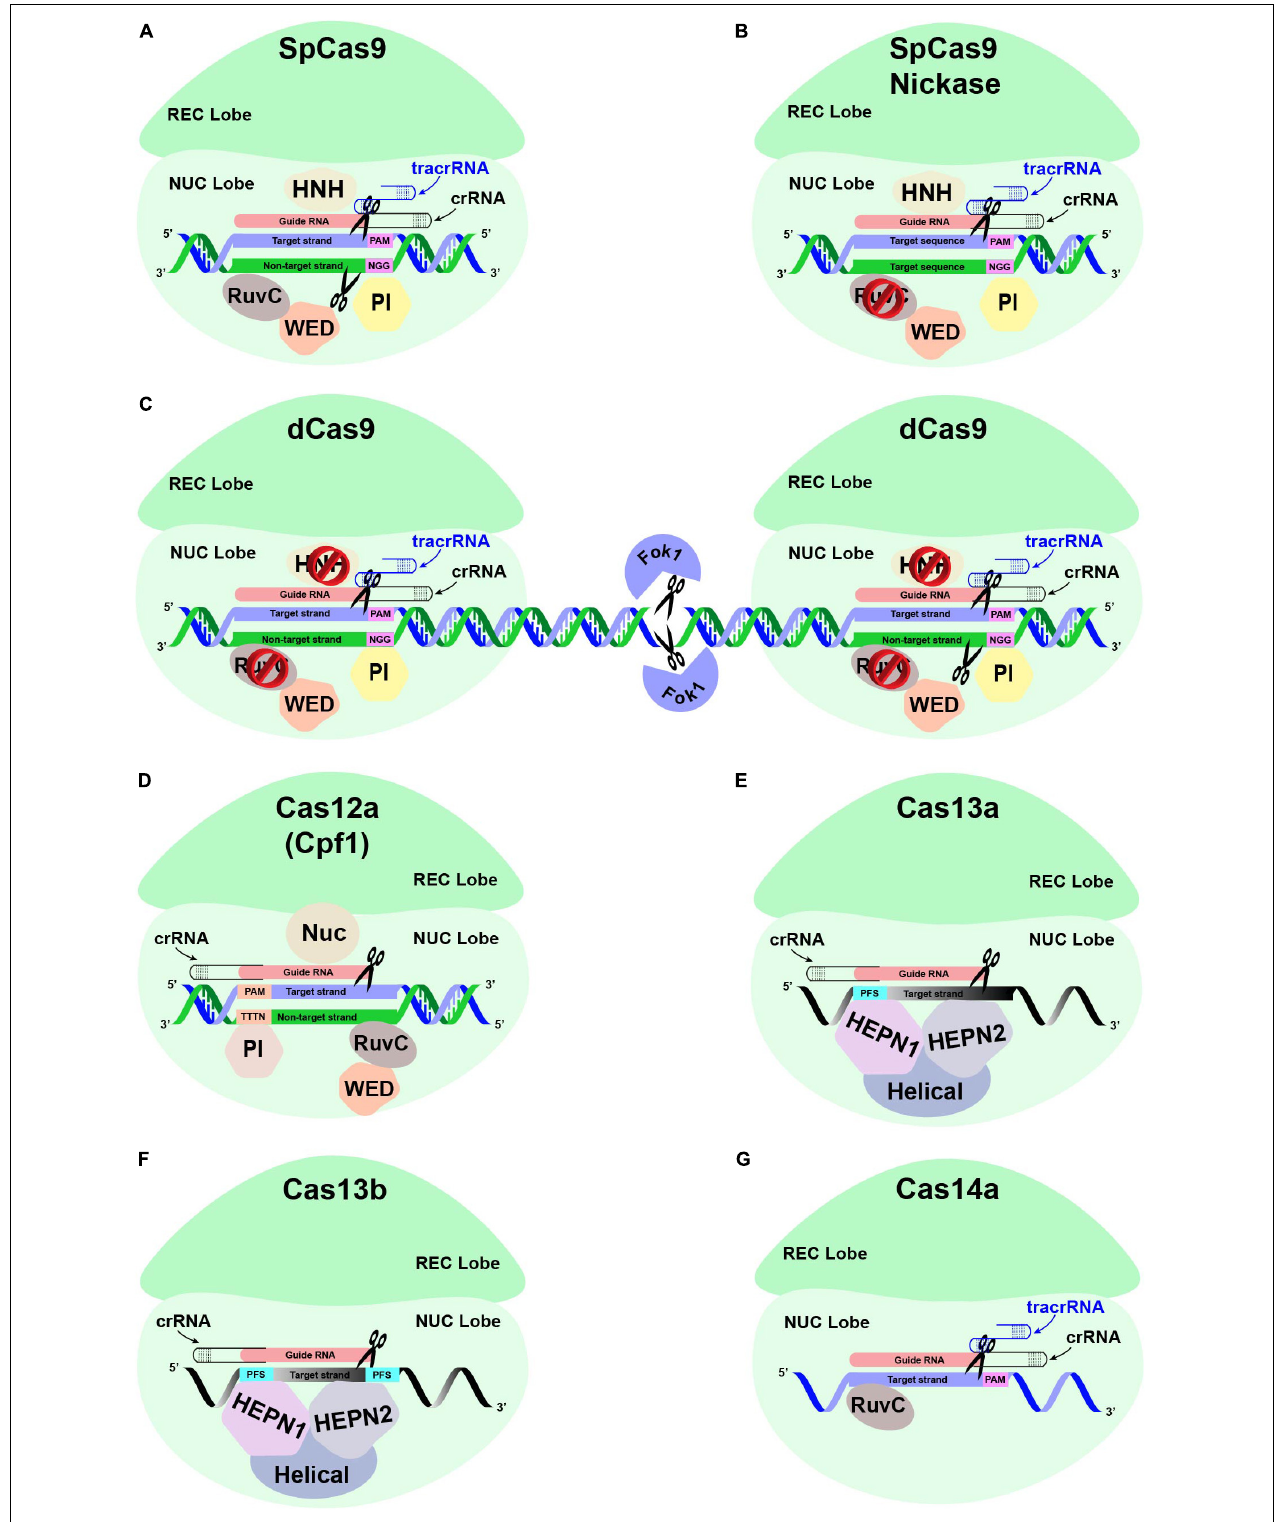
FIGURE 4 | Different Cas proteins that have been opted widely to engineer antiviral resistance in plants. (A) The conventional CRISPR-Cas9-based genome editing is mediated through a single effector protein Cas9, the crRNA, and a tracrRNA. The crRNA and tracrRNA associated with Cas9 endonuclease are hybridized